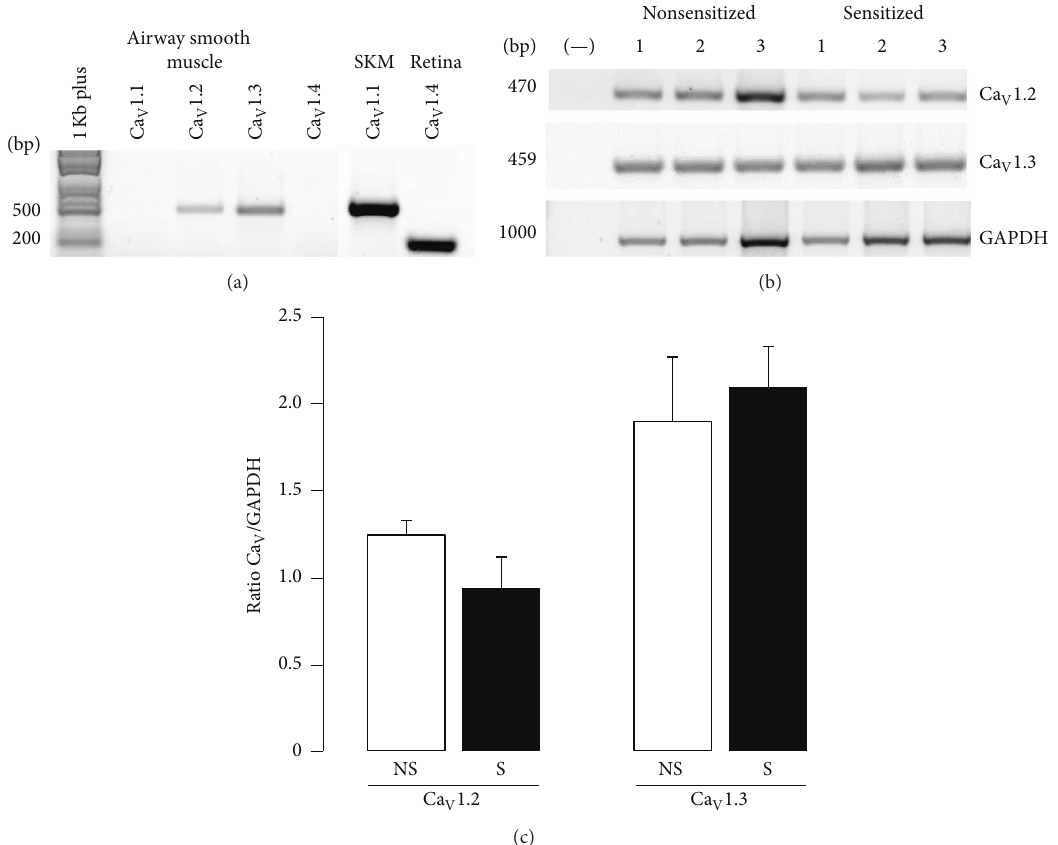
Figure 5: Detection of mRNA for L-VDCC subunits in guinea pig tracheal smooth muscle, as revealed by RT-PCR. (a) In airway smooth muscle, the PCR products at 470 and 459 bp length correspond to Ca V 1.2 and Ca V 1.3 cDNA, respectively. In this tissue, Ca V 1.1 and Ca V 1.4 were not found. Positive controls for these subunits were skeletal muscle (SKM, ∼ 500 bp) and retina ( ∼ 200bp). Lane at the left corresponds to 1Kb Plus DNA Ladder. (b) Representative PCR blots for Ca V 1.2 and Ca V 1.3 from nonsensitized (NS, 𝑛 = 3 ) and sensitized (S, 𝑛 = 4 ) smooth muscles. The first column in each blot corresponds to a negative control without template. The lower panel displays constitutive cDNA of GAPDH. (c) Densitometry data analysis for mRNA from Ca V 1.2 and Ca V 1.3 subunits showing no statistical significance between NS and S. Bars correspond to mean ±